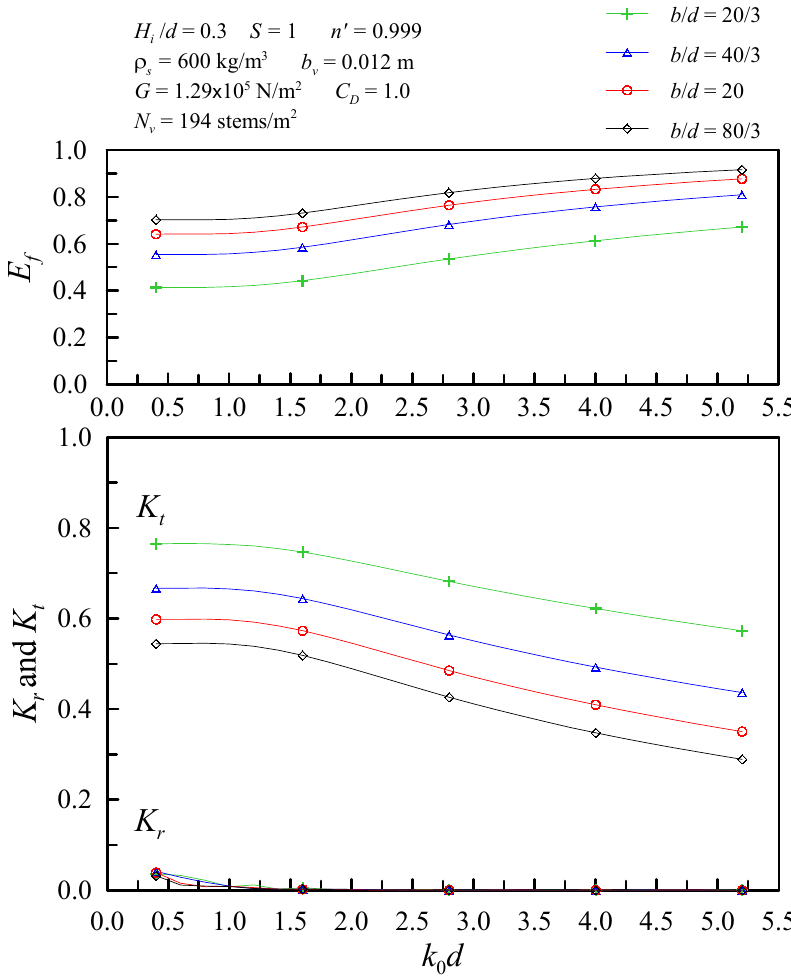
Figure 9. Effect of the dimensionless width db / of vegetation on Figure 9. E ff ect of the dimensionless width b / d of vegetation on K 0.3 m, h / d = 1.0285, b v = 0.012 m, N v = 194 steams / m 2 , C D = 1.0, S = 1, µ = 0.333, n (cid:48) = 0.999, ρ / m 3 , ρ / m 3 , ν = 1.12 × 10 − 6 m 2 / s, β = 4.35 × 10 − 10 m 2 / N, and G = 1.29 × s = 600 kg w = 1000 kg 10 5 N / m 2